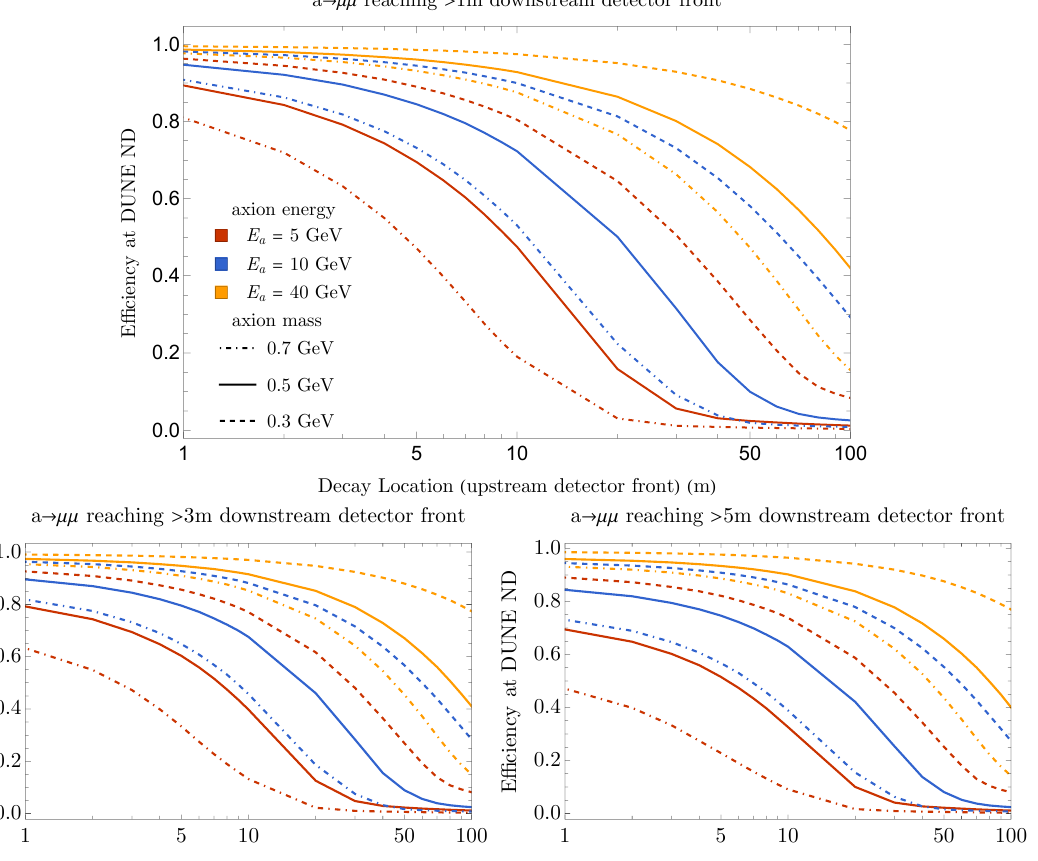
Figure 4 . The signal axion decay geometrical acceptance, as a function of decay location before the front panel of the detector (upstream) for various axion masses and energies. Depending on the background rejection requirement and the actual performance of the detector, one might require a certain track length for the dimuon signals. As most of the axions are boosted, the decay is forward, so most of the signal will penetrate the whole detector. We show the acceptance fraction by requiring both the muons to arrive at least 1 meter (upper panel), which is equivalent to a track length of more than 1 meter, 3 meters (lower left panel), and 5 meters (lower right panel). The red, blue, and yellow curves correspond to axion energy of 5, 10, and 40 GeV, respectively. The dashed, solid, and dot-dashed curves correspond to axion masses of 0.3, 0.5, and 0.7